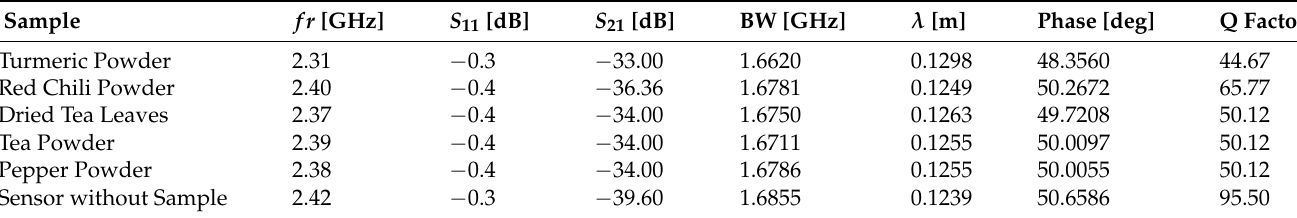
Figure 23. Senor testing in solid samples: ( a ) variation in scattering parameters with frequency; ( b ) variation in transmission coefficient parameters with frequency. Table 7. Solid sample